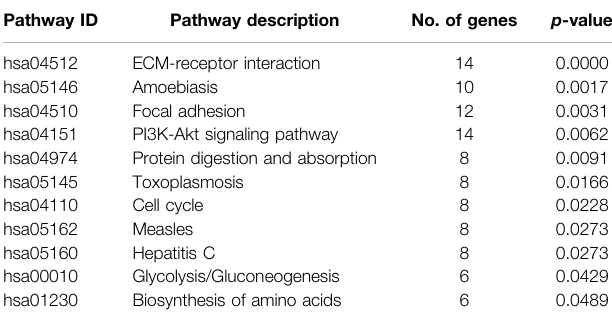
TABLE 6 | Signi fi cant pathways for the top 50 hub genes from the PPI network of the host genes of the DE circRNAs. Pathway ID